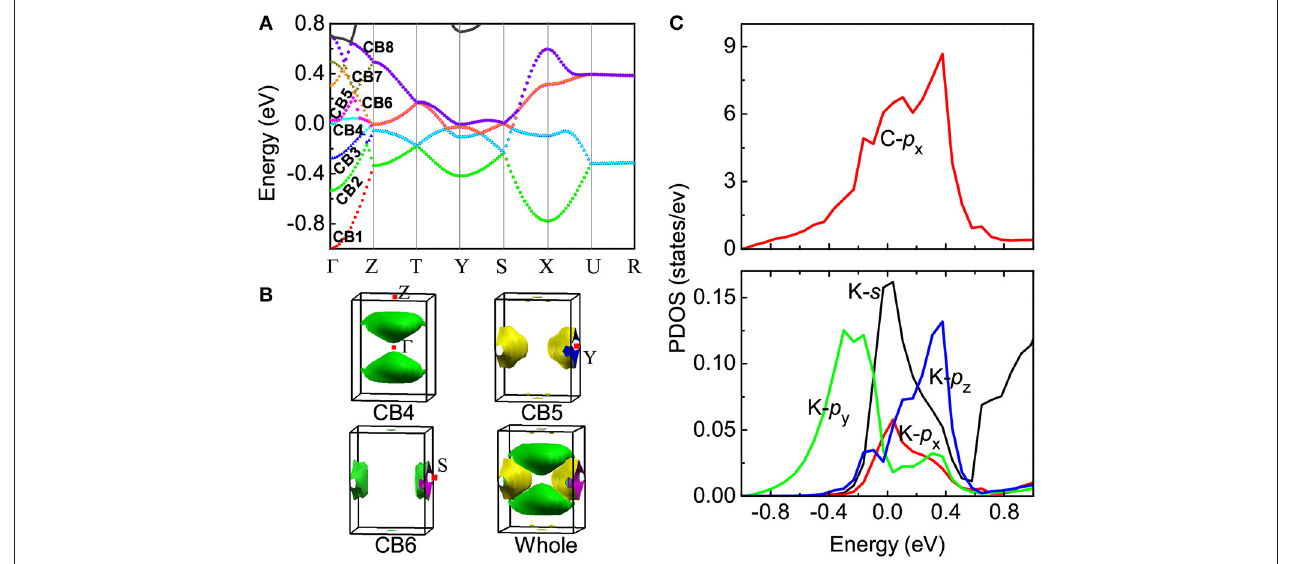
FIGURE 2 | Electronic band structure of K 2 C 6 H 6 . (A) Energy band; (B) fermi surface; (C) projected density of states (PDOS), where zero energy denotes the Fermi